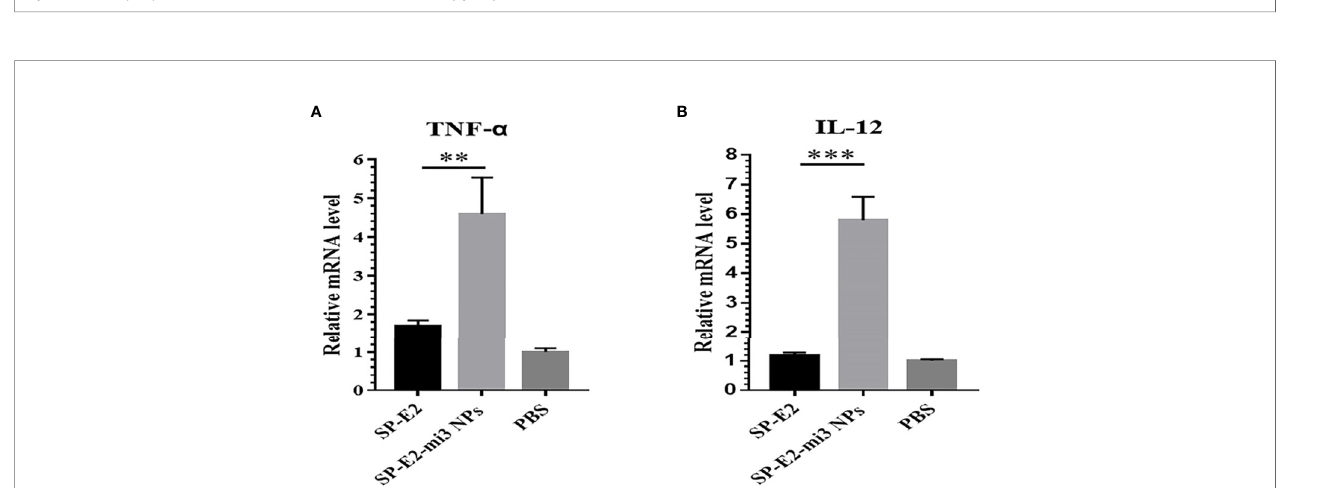
FIGURE 4 | Antigen internalization induced immunostimulatory effects in vitro . After exposed to FITC-SP-E2 or FITC-SP-E2-mi3 NPs for 2 h, total RNAs were isolated from stimulated PAMs, and mRNA levels TNF- a (A) and IL-12 (B) were determined in qPCR, and the data were presented from triplicate experiments. **p < 0.01; ***p <